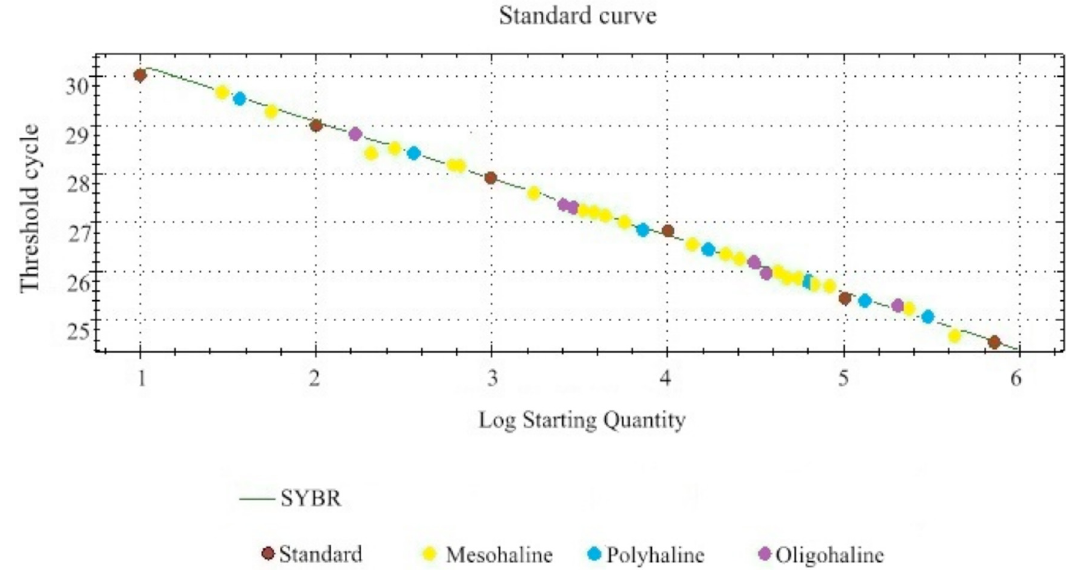
Fig. 5. Standard curve showing zone wise detections of M. rosenbergii larvae.